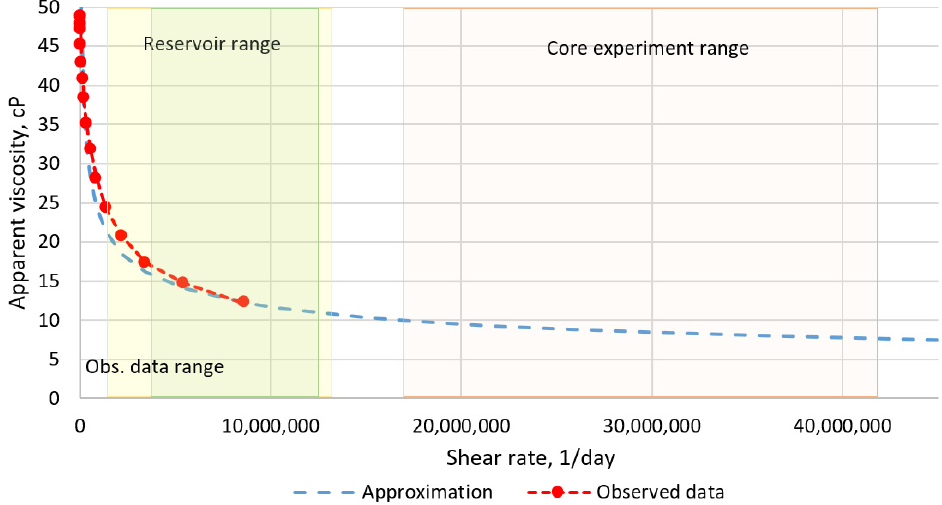
Figure 5. Effect of shear rate on the viscosity of the polymer solution.